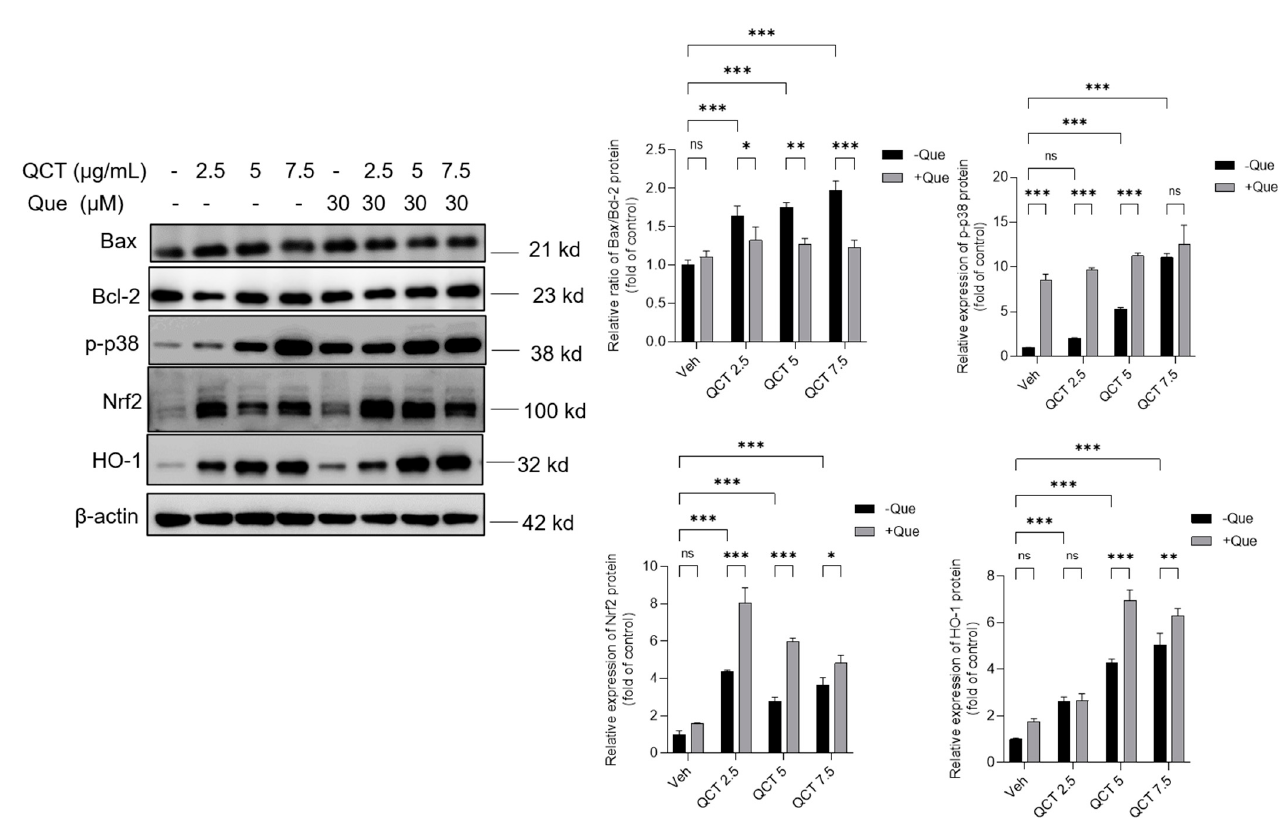
Figure 7. Quercetin supplementation upregulated the expression of Nrf2, HO ‐ 1, p ‐ p38, and Bcl ‐ 2 proteins and downregulated Bax proteins in human L02 cells. QCT ‐ alone treatment was performed at final concentrations of 2.5, 5, and 7.5 μ g/mL with or without quercetin at a final concentration of 30 μ M for 24 h, and the expression of Bax, Bcl ‐ 2, p ‐ p38, Nrf2, and HO ‐ 1 proteins was examined using the Western blot method. The representative images were shown (on the left) and the values of each band were quantified using Image J (on the right). All results were presented as mean ± SD ( n = 3 independent experiments). * p < 0.05, ** p < 0.01, and *** p < 0.001, compared between the two groups. QCT, quinocetone; Que, quercetin; ns, no significance.